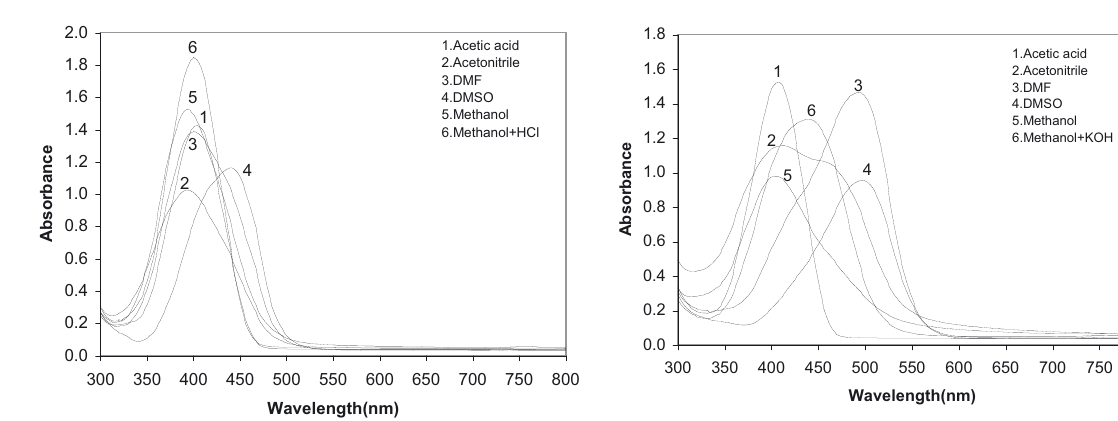
Figure 2. Absorption spectra of dye 2 in various solvents and basic solution.